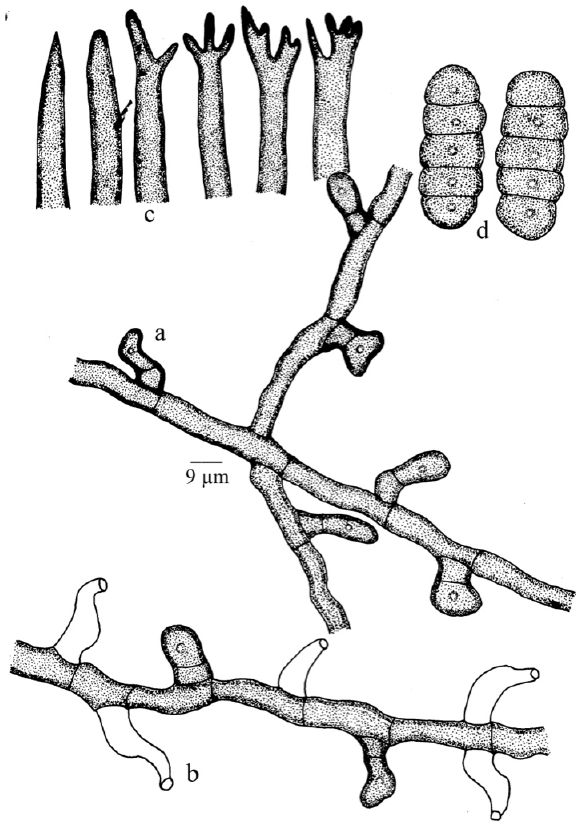
Figure 17. Meliola ternstroemiicola sp. nov. a - Appressorium, b - Phialide, c - Apical portion of the mycelial setae; d -